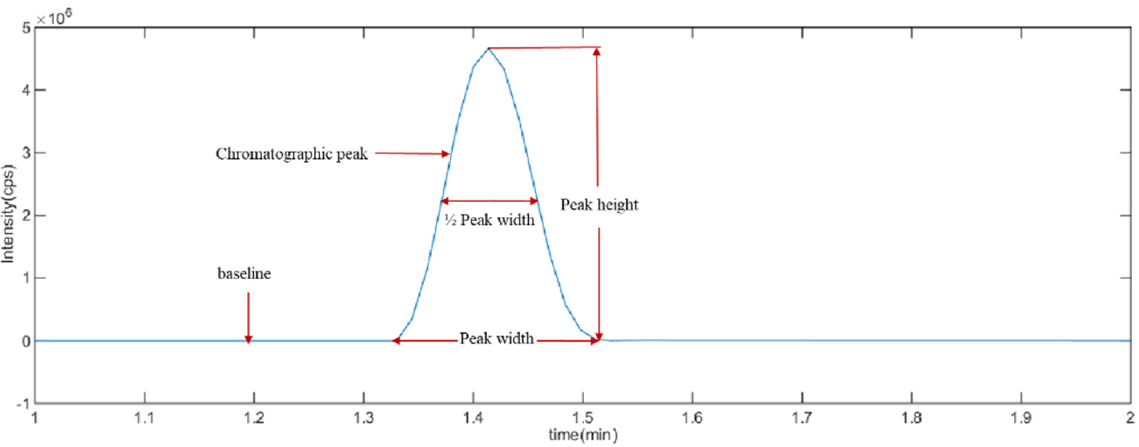
Figure 1. An example of a chromatographic signal.